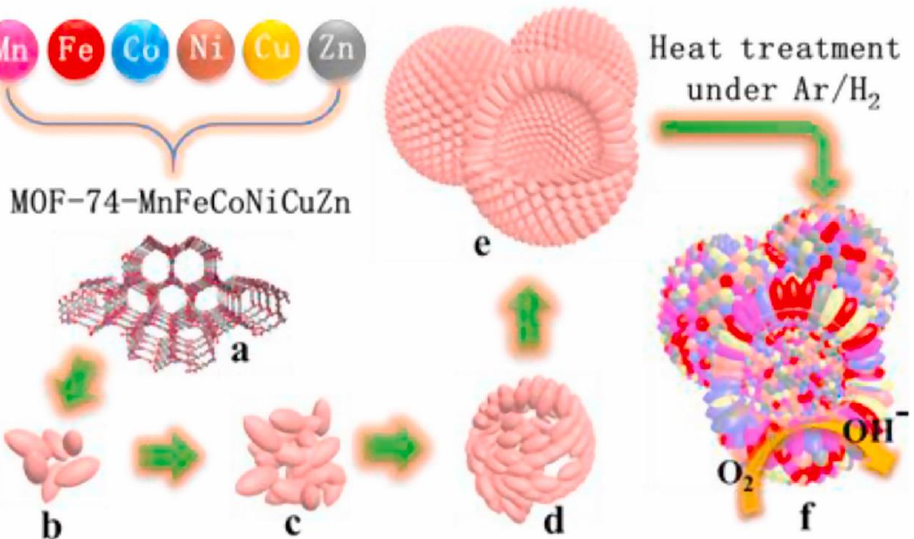
Figure 21. Schematic diagram of porous hollow high-entropy alloy catalyst production. ( a ) Crystal structure of MOF-74-H. ( b ) Small number of MOF particle aggregated. ( c ) Large number of MOF particle aggregated. ( d ) Secondary nucleation. ( e ) Dissolution regrowth-formation of hol- low multi-metal-organic framework. ( f ) Hollow metal/metal-alloy/metal-oxide (MOF-74-H-650) nanocomposite for ORR. (Reprinted with permission from [281]. Copyright 2021,